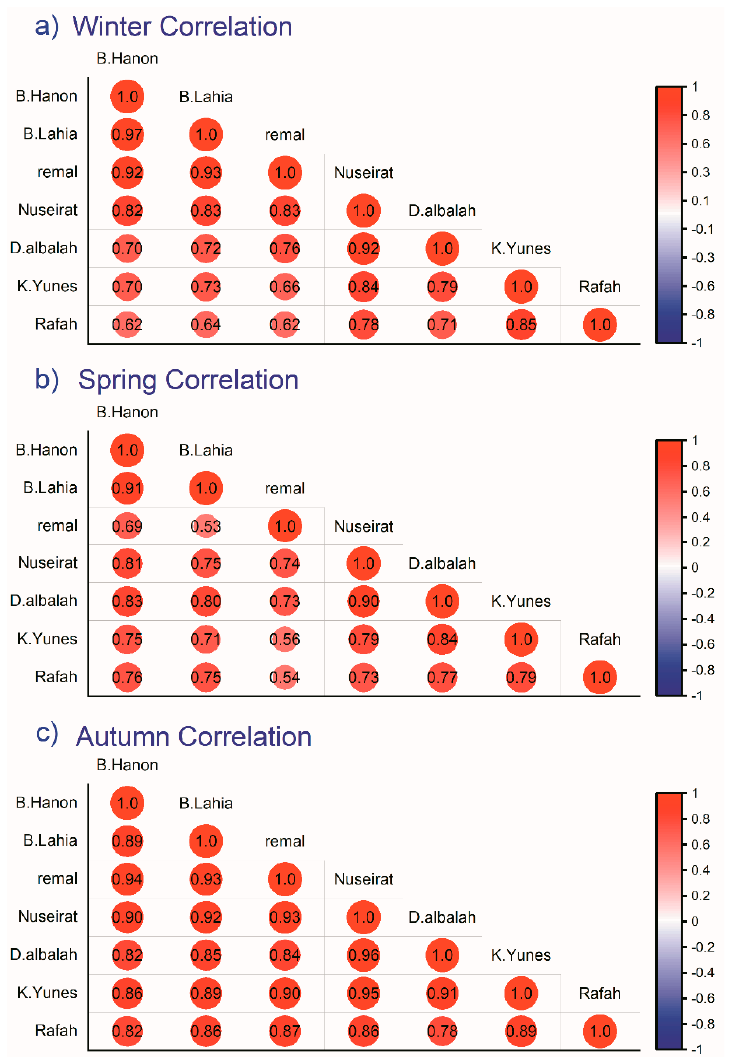
Figure A1. The correlation of seasonal precipitation between Gaza stations.